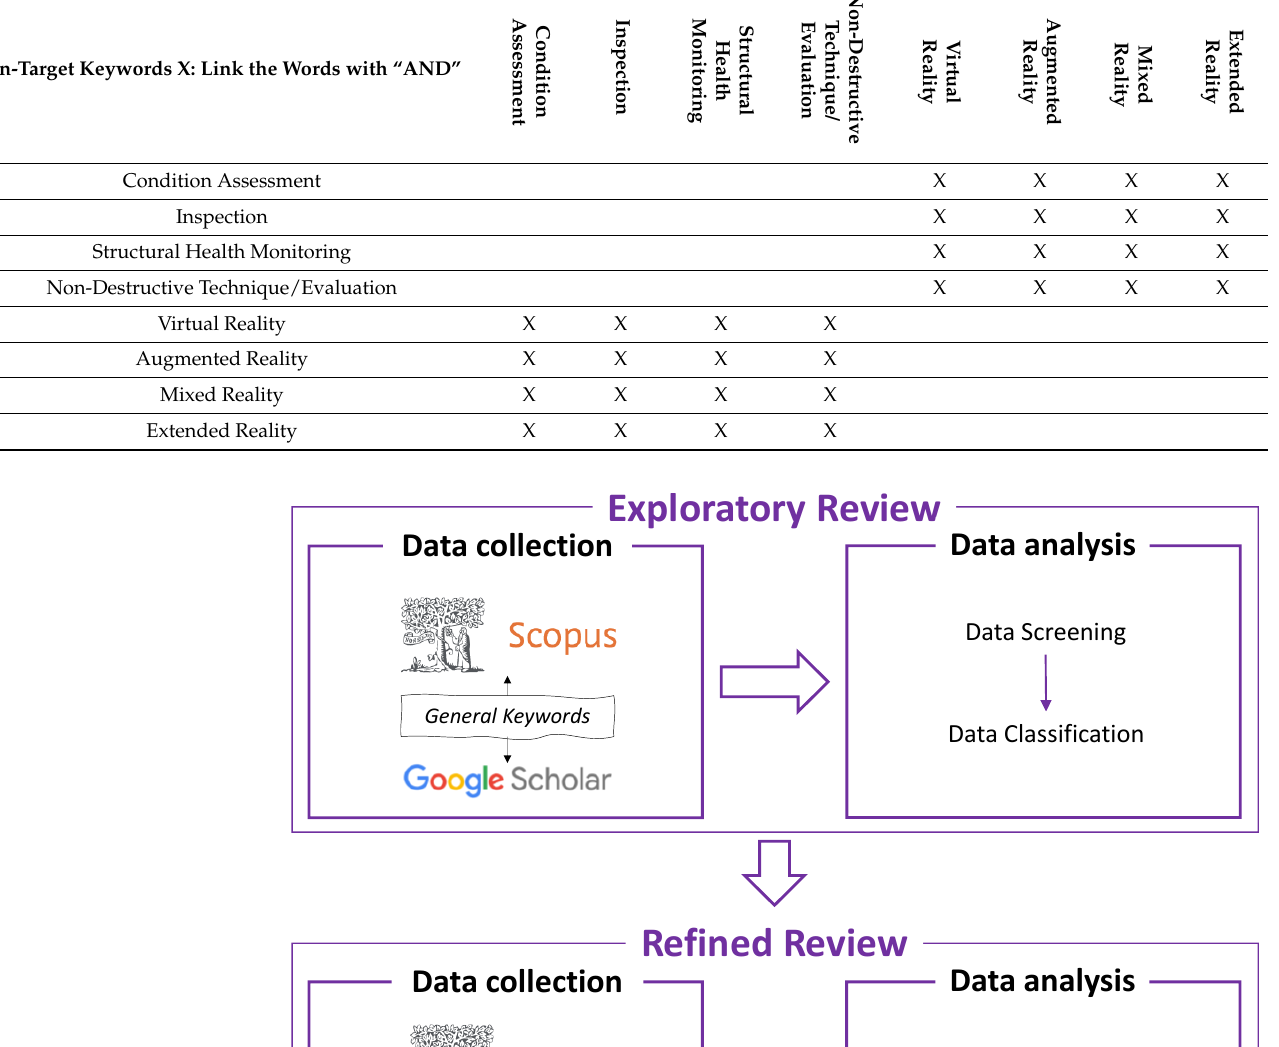
X Table 2. On-target keywords used in the literature search for the Refined Review. On-Target Keywords X: Link the Words with “ AND ”